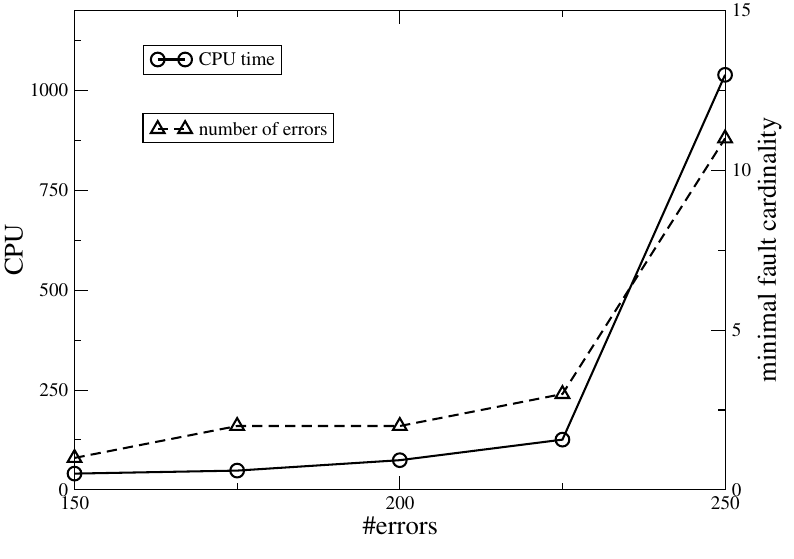
Figure 10. CPU time used by a PB-SAT solver to minimize the number of faulty cells to satisfy a constraint on the minimum number of errors at